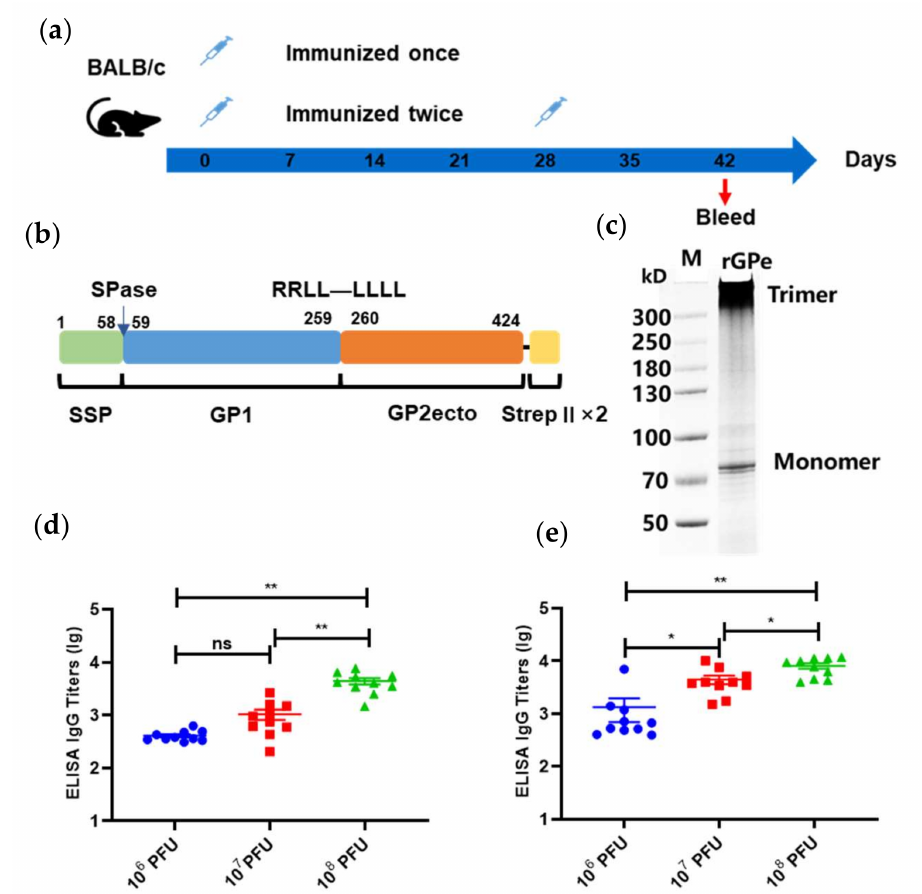
Figure 3. Humoral immune responses after vaccination with Ad5-GPC LASV . ( a ) BALB/c mice ( n = 10 per group) were immunized intramuscularly with doses of 10 6 /10 7 /10 8 plaque-forming units (PFU) of Ad5-GPC LASV once on day 0, or twice, on days 0 and 28. Sera were collected on day 42 post first vaccination. ( b ) Schematic of linked recombinant GPC lacking the transmembrane and intracytoplasmic domains (rGPe). ( c ) LASV rGPe was expressed in the Expi293 suspension cells and purified by affinity chromatography. Purified proteins were assessed on nonreduced SDS-PAGE gel. Humoral immune responses were assessed via LASV GPC-specific ELISA from the sera of mice vaccinated once ( d ) and twice ( e ). Data are presented as mean ± SEM, and statistical significance was determined by one way ANOVA and Turkey’s multiple comparison test (* p < 0.05; ** p <